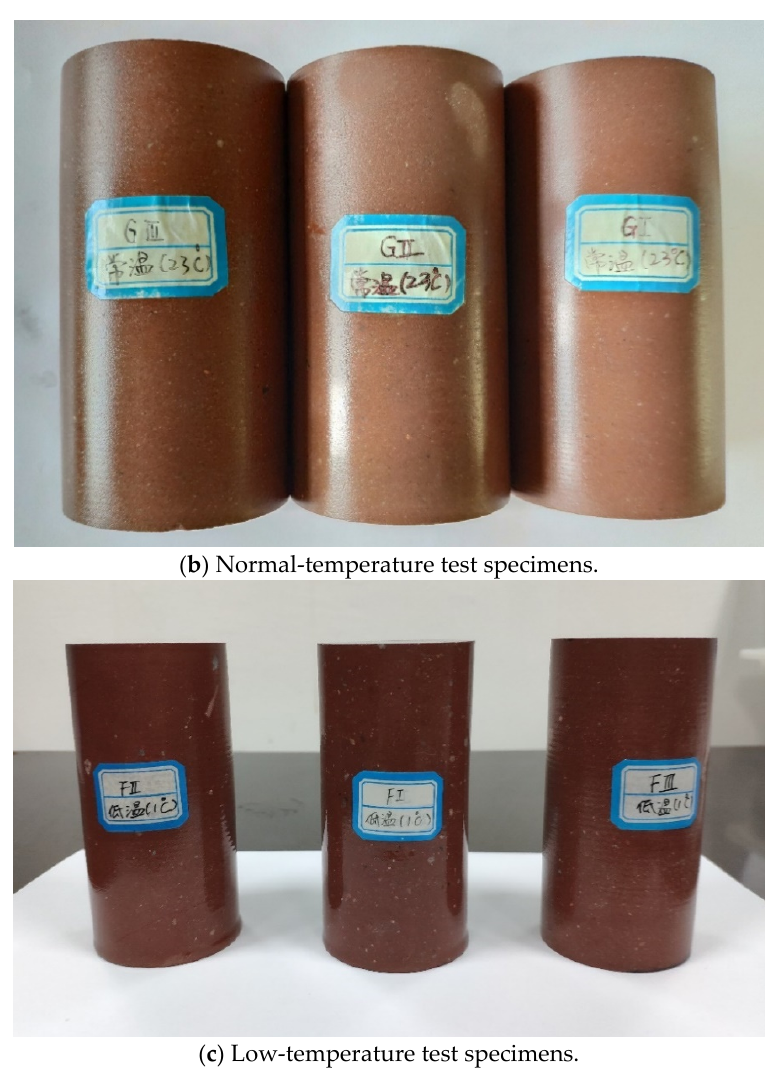
Figure 9. Comparison diagram of the surface visible cracks.